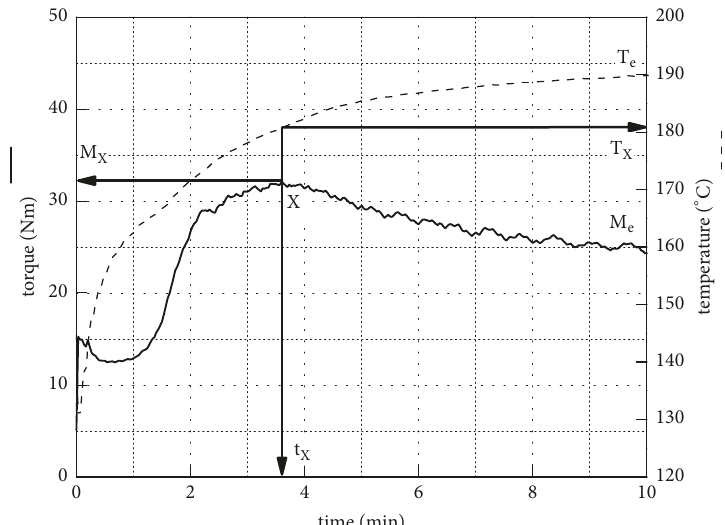
Figure 2: An exemplary plastogram of PVC processing containing 5 wt% GFCD